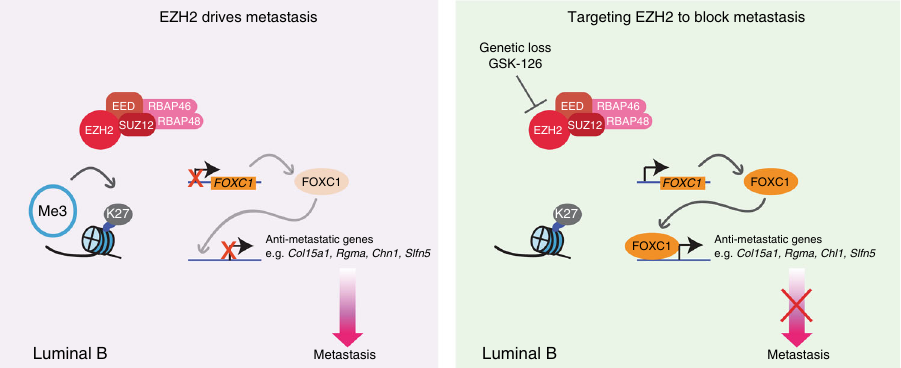
Fig. 8 Proposed model highlighting the bene fi t of targeting Ezh2 in Luminal B breast cancer. Schematic illustrates Luminal B-speci fi c PRC2-mediated suppression of a FOXC1-dependent anti-metastatic transcriptional program, and establishment of FOXC1 expression following ablation of EZH2 or pharmacological inhibition of EZH2 methyltransferase activity leading to FOXC1-dependant expression of